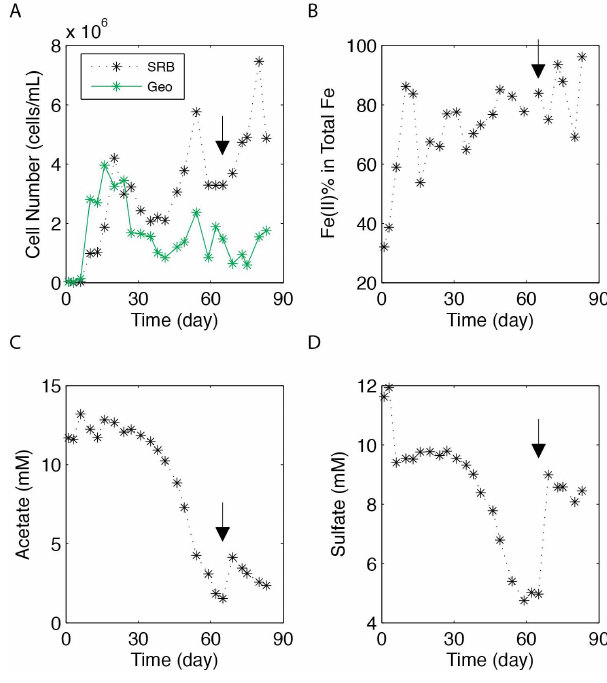
Fig. 1. Microbiological and geochemical impact of adding acetate to subsurface sediments. (A) The number of cells of Geobac- ter and sulfate-reducing bacteria (SRB) as determined by flu- orescent in situ hybridization of probes GeoA/GeoB/GeoC and SRB385/SRB385Db, respectively; (B) Fe(III) reduction as indi- cated by an increase in the proportion of Fe(II) of the total acid- extractable iron in the sediment; (C, D) The concentration of ac- etate (C) and sulfate (D) in the groundwater; The arrow denotes an addition of sterile groundwater to the batches that aimed to increase both acetate and sulfate by 5mM each; Data points are each an av- erage of 5 separate